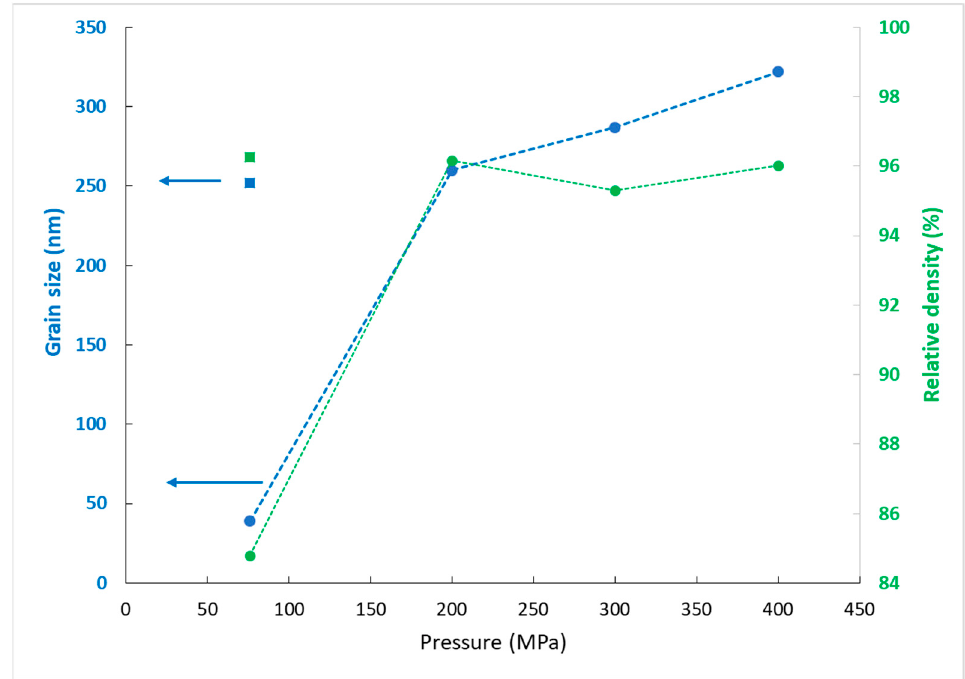
Figure 8. Evolution of grain size and relative density as a function of pressure for a thermal cycle up to 700 °C .